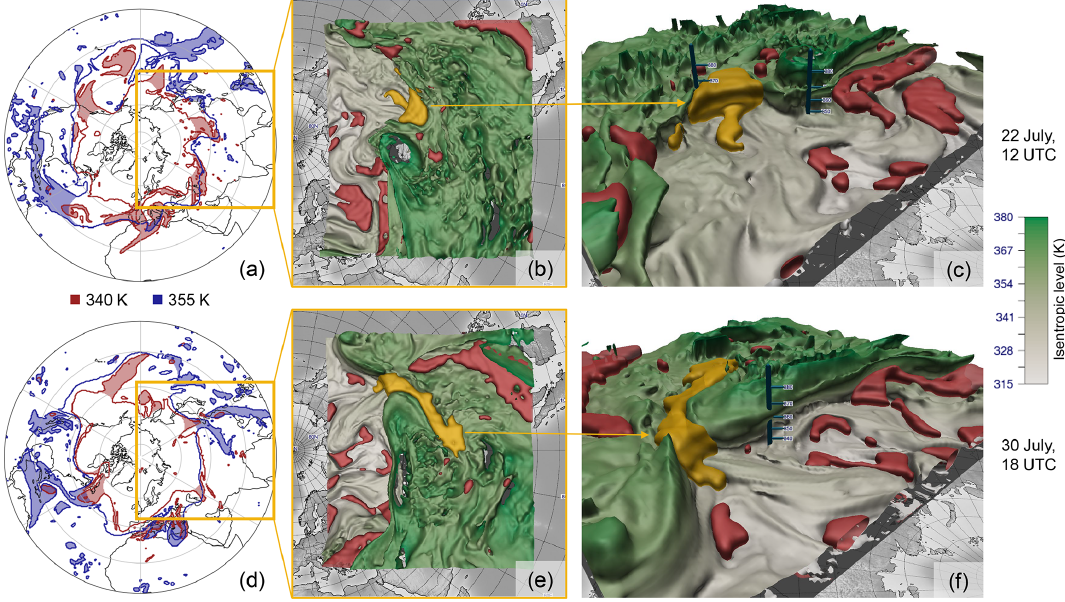
Figure 14. Comparison of the 340 and 355K isentrope and the corresponding 3-D analysis for two time steps throughout the case study. (a) The 2-D analysis on 22 July, 12:00 UTC, where the anomaly is identified at 340K (red) but not at 355K (blue); (b) top–down view of the 3-D analysis; (c) side view of the 3-D anomaly. (d) – (f) Same as (a) – (c) but 8d later. The anomaly is now identifiable at 355K but not at 340K anymore. Therefore, a 2-D analysis of the event considering a single isentrope is insufficient.